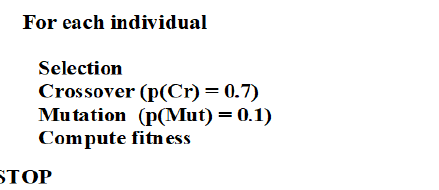
Figure 5. Pseudocode of particle swarm optimization algorithm.